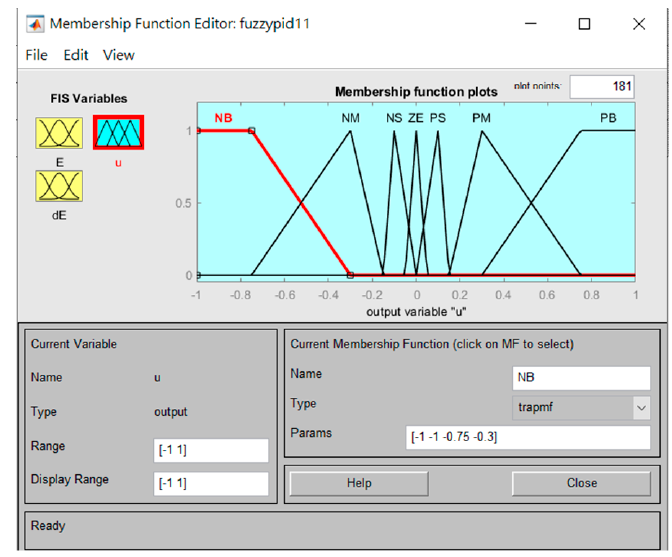
Figure 10. Membership function for input variable “ Δ E”.